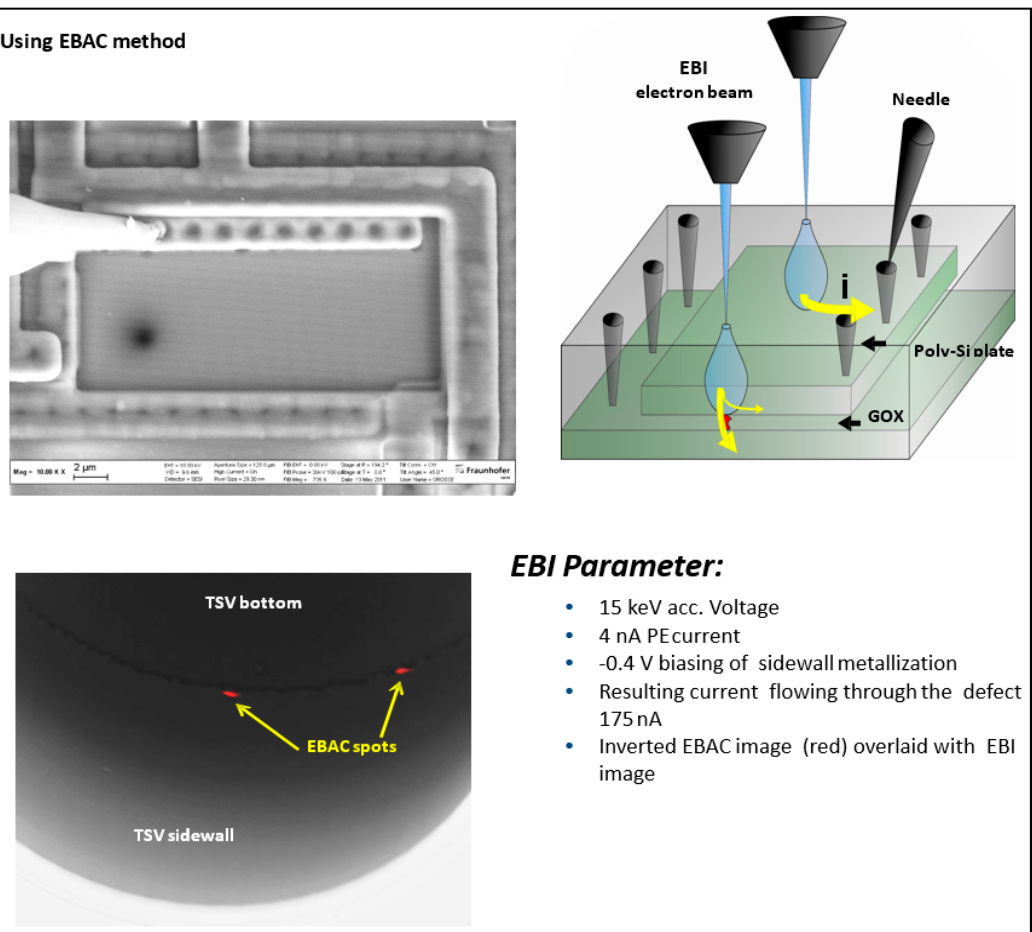
Figure 19. Principle of inverted Electron Beam Absorbed Current (EBAC) image used to overlay EBI image and detect a defect.